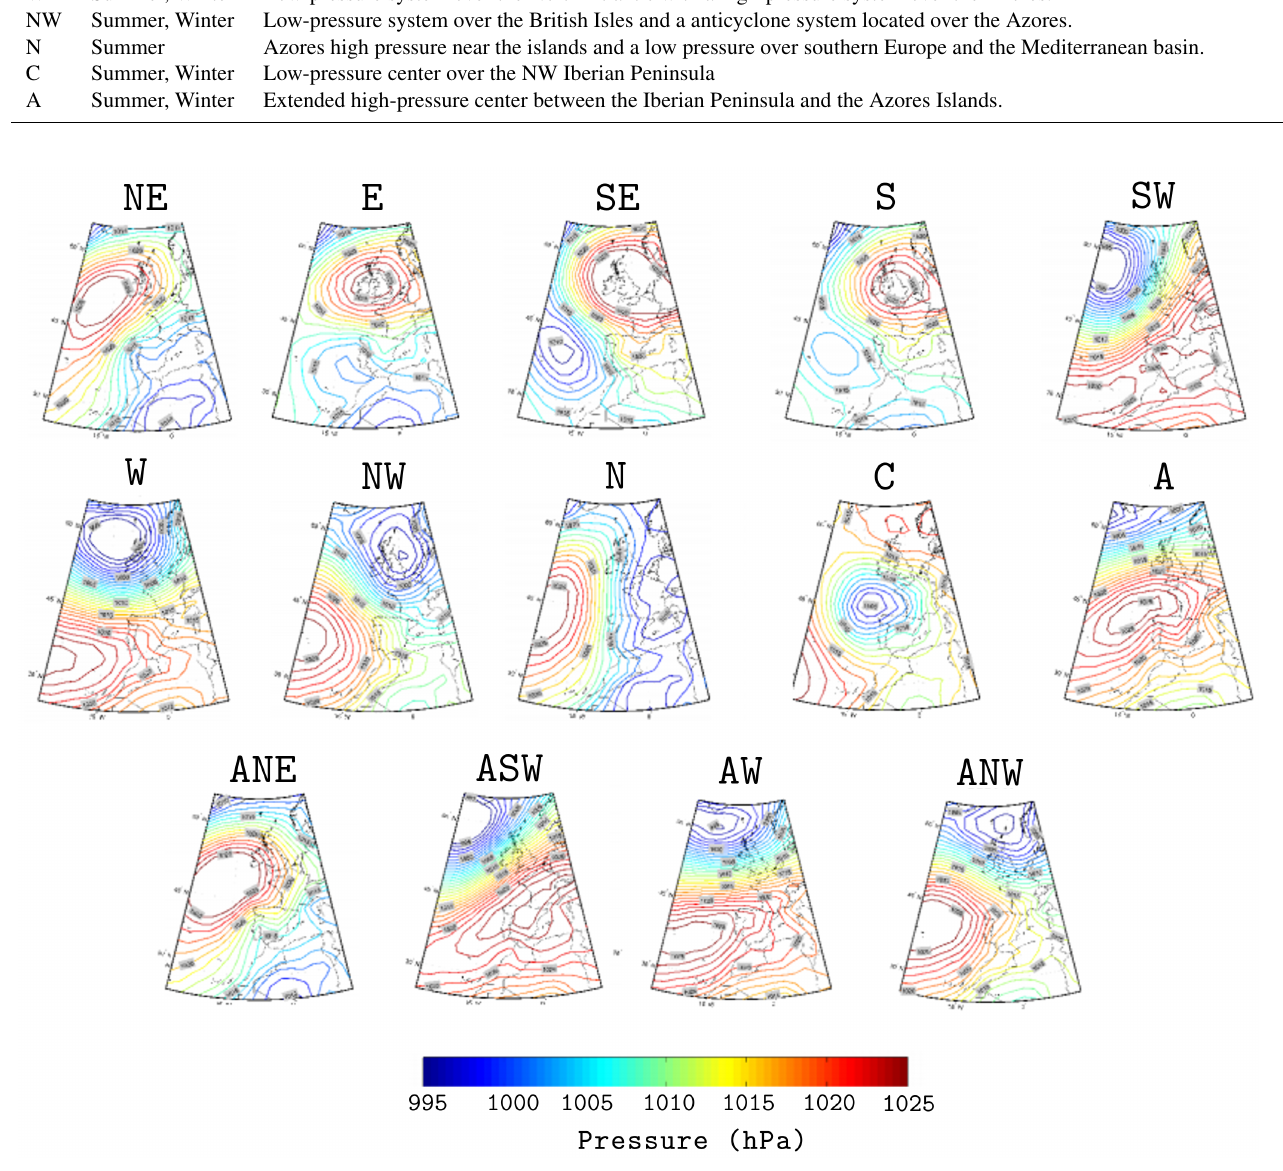
Figure 3. SLP composites for all the WTs considered in this analysis.